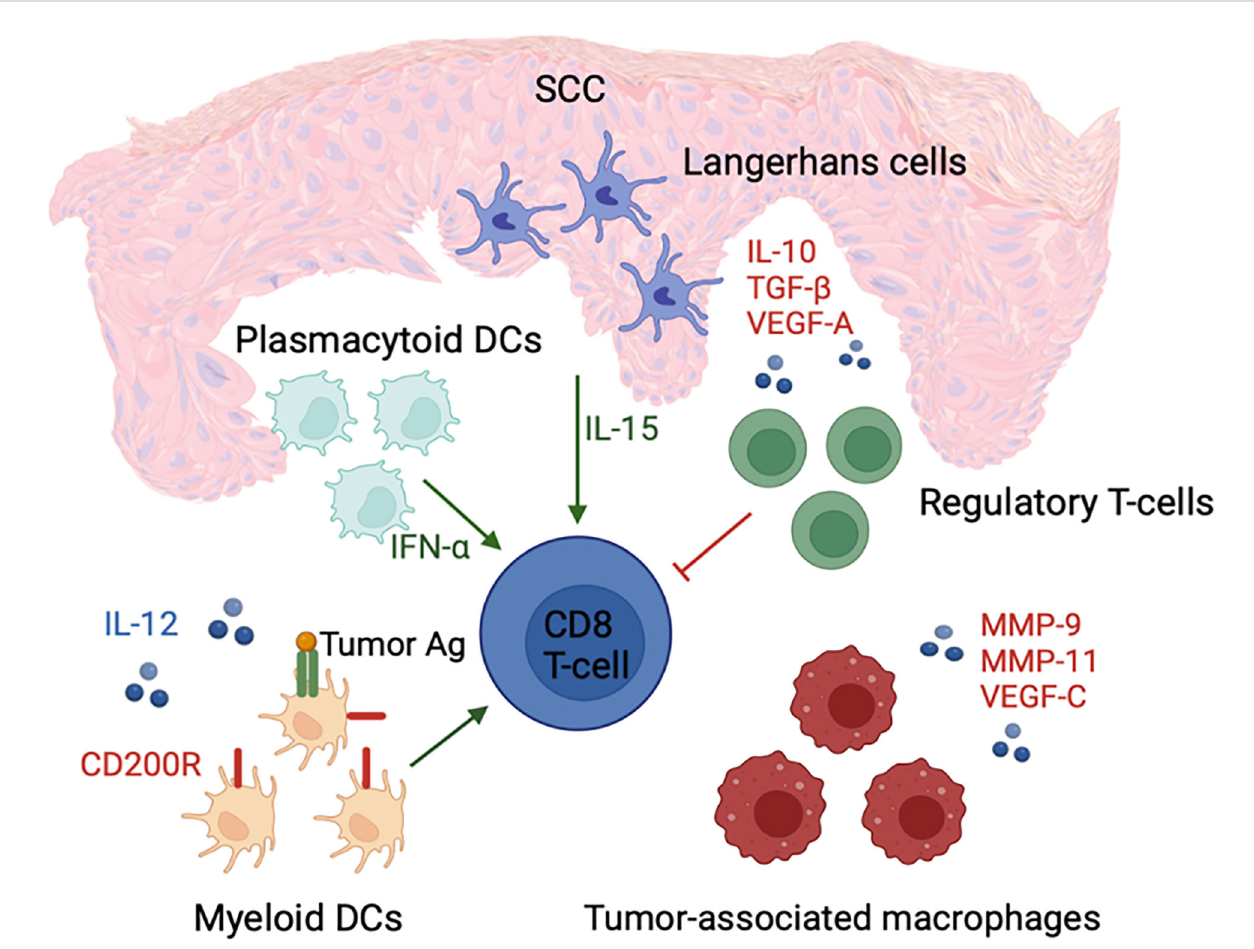
FIGURE 3 cSCC microenvironment is associated with an increased number of IFN- a -secreting pDCs and LCs with enhanced ability to activate CD8+ T cells, which potentially promote immunosurveillance. In contrast, an increased number of regulatory T cells; tumor-associated macrophages; and immune suppressive cytokines, such as IL-10, TGF- b , and VEGF-A, are present in the tumor microenvironment. These factors contribute to tumor growth and immune dysfunction through suppression of mDC and CD8+ T cell